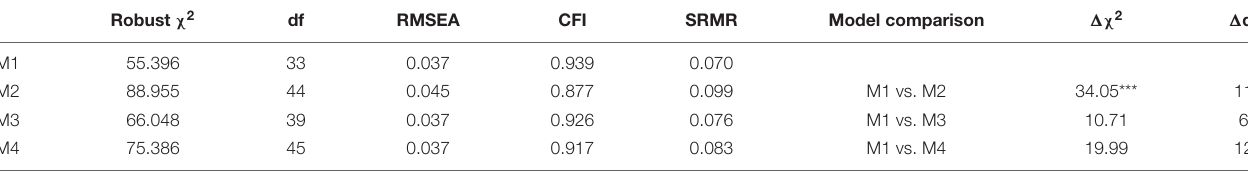
TABLE 2 | Fit indices of the auto-regressive cross-lagged models. Robust χ 2 df RMSEA CFI SRMR Model comparison (cid:49) χ 2 (cid:49) df